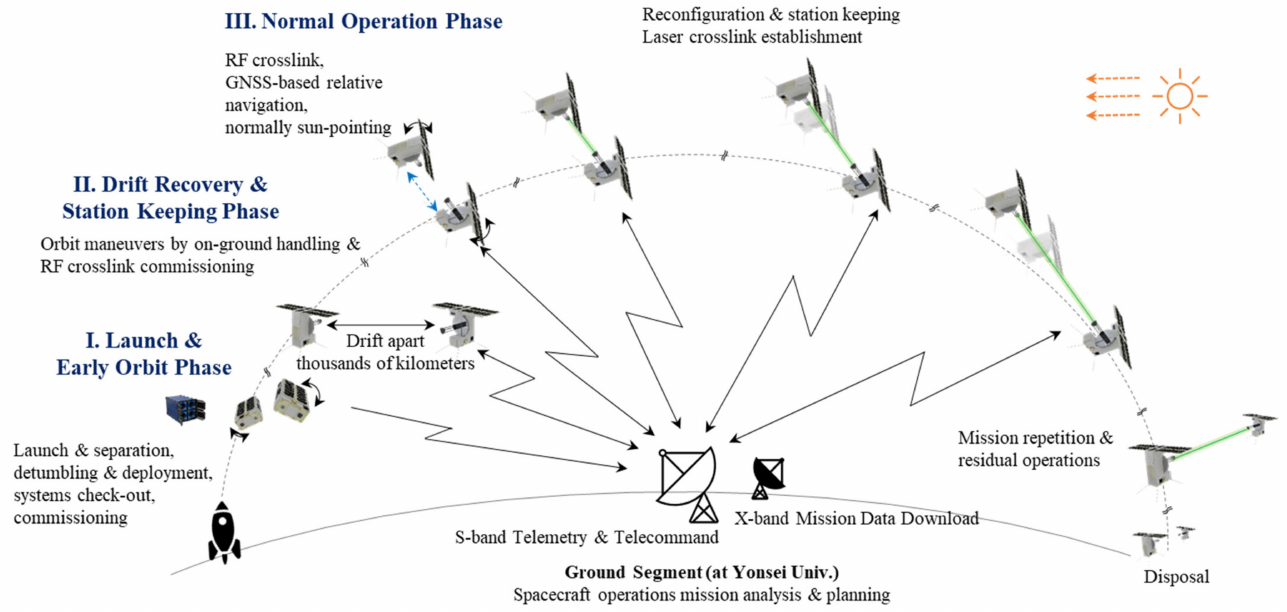
Figure 2. Concept of operations for the VISION mission. After the early orbit operations, the two CubeSats adjust their distances. For each specific distance, they maintain over 10 days to conduct the laser crosslink